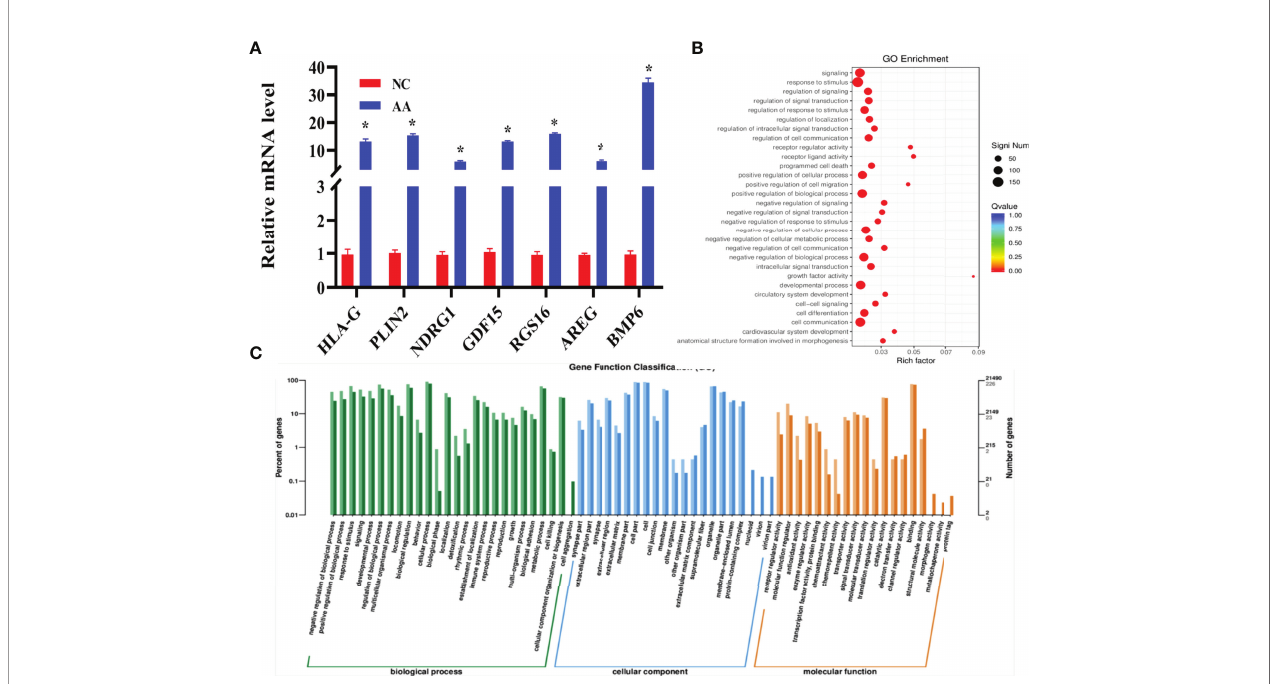
FIGURE 5 | RNA sequencing and bioinformatics analysis and validation by qRT-PCR analysis (A) Relative expression of seven selected mRNA was quanti fi ed by qRT-PCR. Compared with the NC group, HLA-G 、 PLIN 、 NDRG1 、 GDF15 、 RGS16 、 AREG and BMP6 displayed an increased expression in the AA group (B) GO annotation showed that the differentially expressed cells were associated with different biological processes. (C) Gene Ontology (GO) classi fi cation of differentially expressed cells. Data represent mean ± standard error, *P < 0.05.